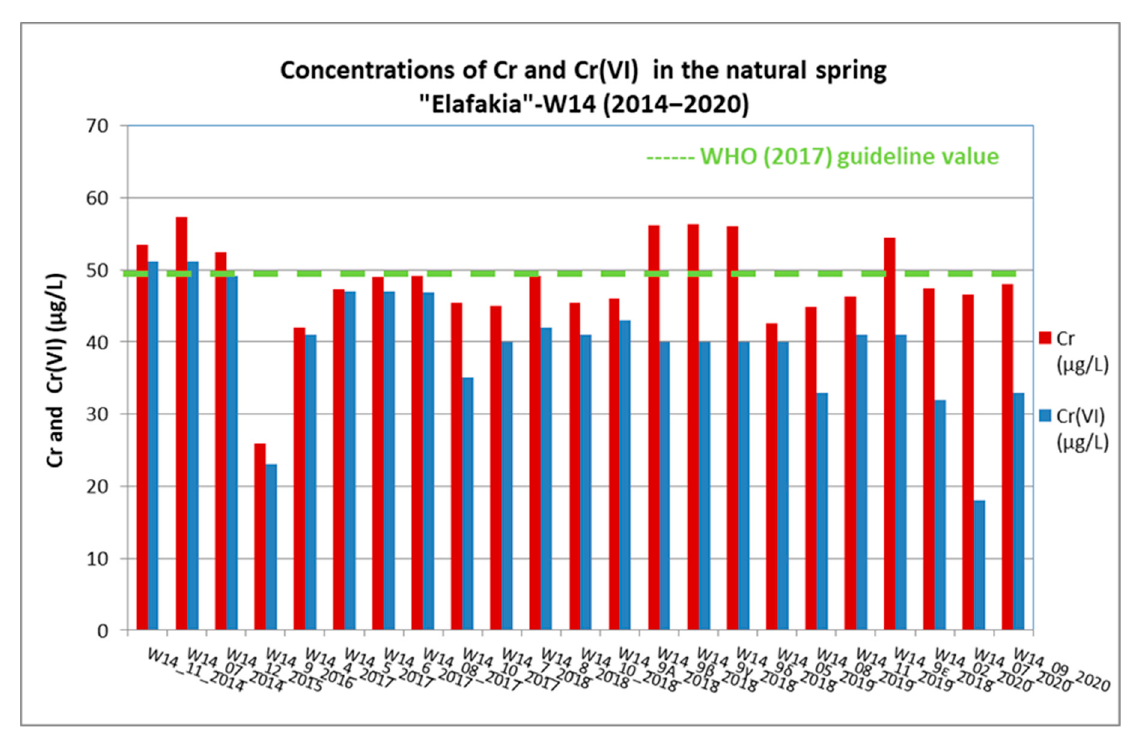
Figure 9. Concentrations of Cr and Cr(VI) in the natural spring “Elafakia” ‒ W14 of western Vermio Mt.